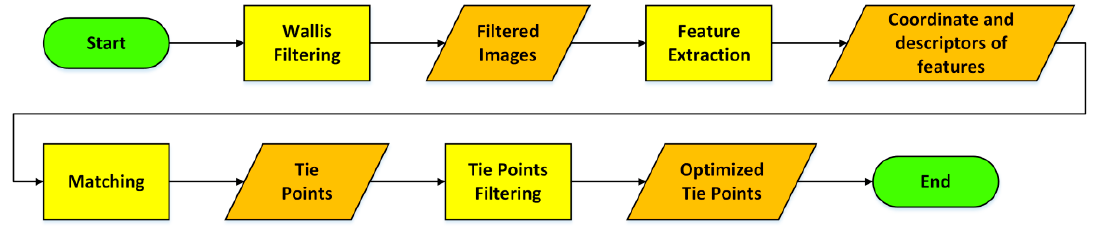
Figure 1. Methodological workflow describing tie point extraction.